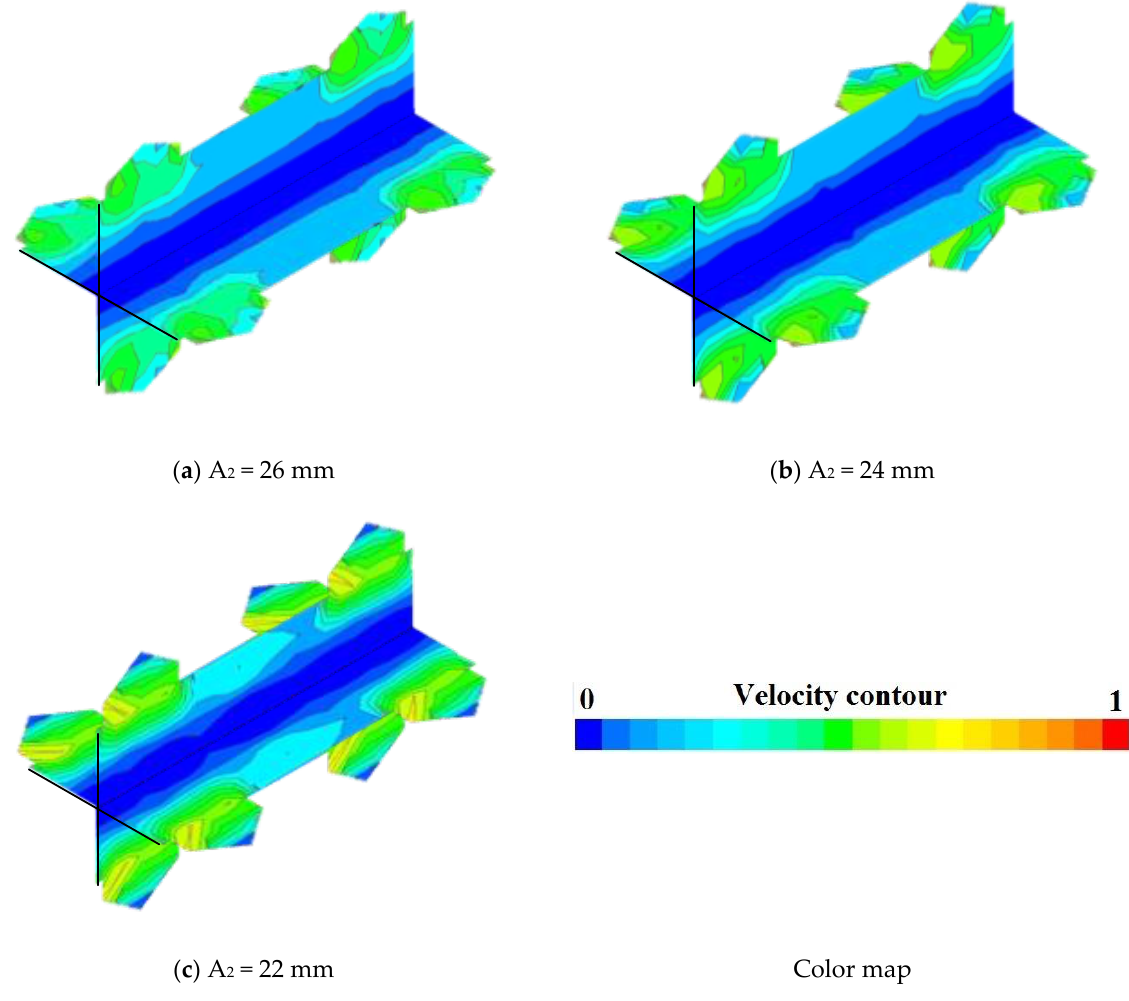
Figure 11. Velocity magnitude contours for various configurations of Case A with different A 2 parameters at R = 15 mm, Re = 15,000, and 𝜑 = 0.5%.